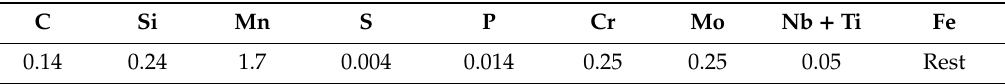
Table 1. The chemical composition in wt. % of the studied steel.